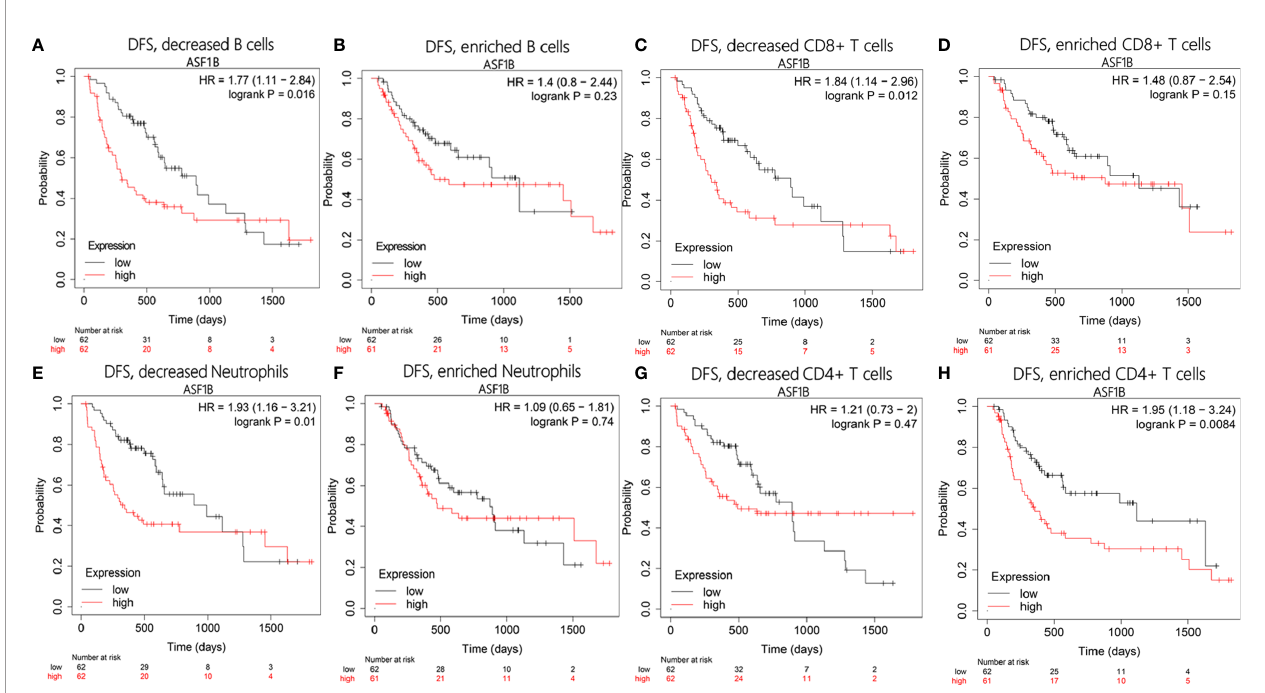
FIGURE 10 | Disease-free survival analysis of ASF1B in following immune cells in fi ltration subgroups: (A, B) B cells, (C, D) CD8+ T cells, (E, F) Neutrophils, (G, H) CD4+ T